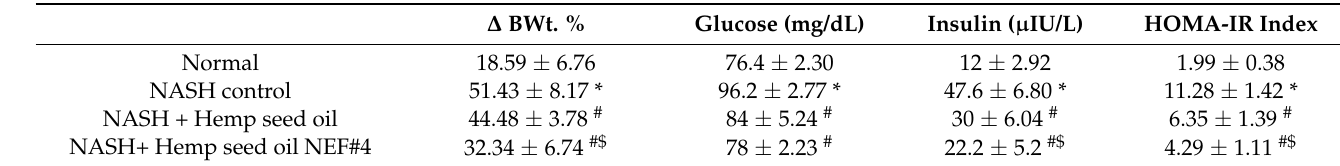
Table 5. Effect of the hemp seed oil NEF#4 on body weight, blood glucose, insulin, and insulin resistance index in rats with NASH.